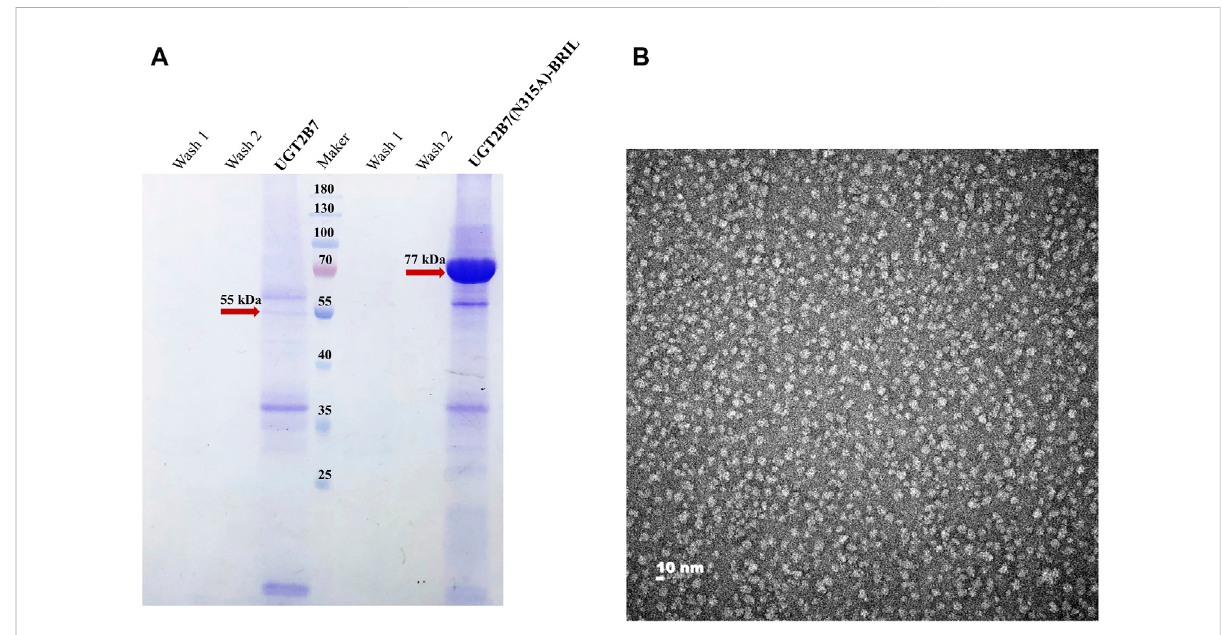
FIGURE 4 Characterization of UGT2B7(N315A)-BRIL. (A) Coomassie blue staining polyacrylamide gel electrophoresis of the wide type UGT2B7 (55 kDa) and UGT2B7(N315A)-BRIL (77 kDa). (B) Negative-staining TEM analysis of the UGT2B7(N315A)-BRIL protein particles at 180,000 × magni fi cation.